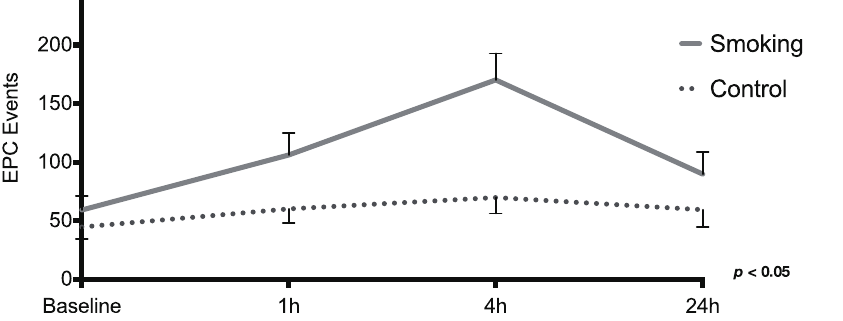
Figure 2. Endothelial progenitor cells during smoking and control. Endothelial progenitor cells were measured as CD34 + KDR + double positive cells during smoking and control visit. Data are presented as events of endothelial progenitor cells (mean 6 SE). Statistical differences (two- factor ANOVA) are indicated in the figure.